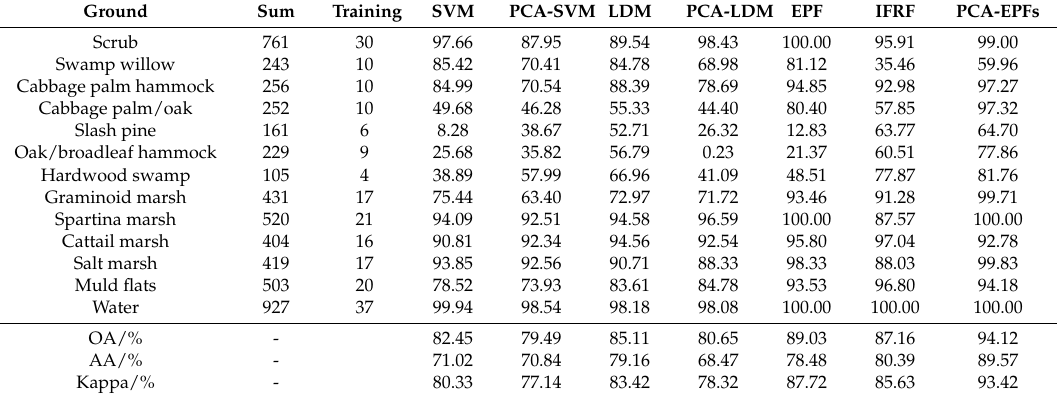
Table 5. Comparison of classification accuracies (in percent) provided by seven methods for Kennedy Space Center (part A).